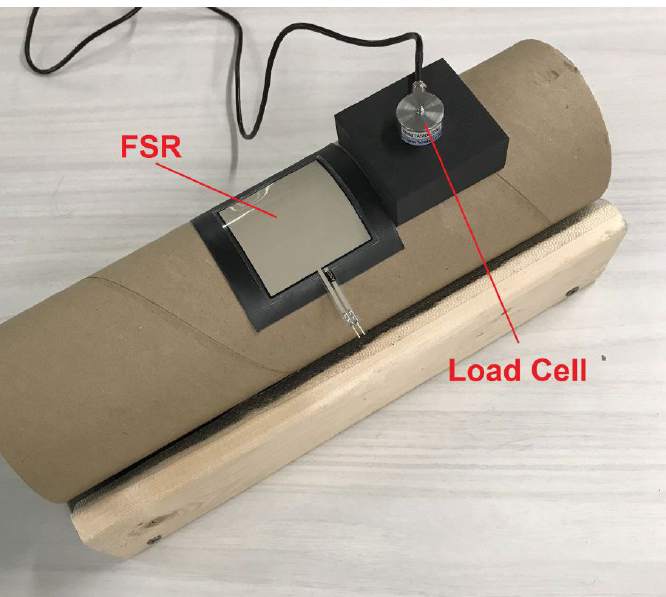
Figure 3. The FSR sensor calibration setup: an FSR was attached to the tube. The tube is made of structural paper which is the same material used to made the chair. When calibrating, the load cell was placed on top of the